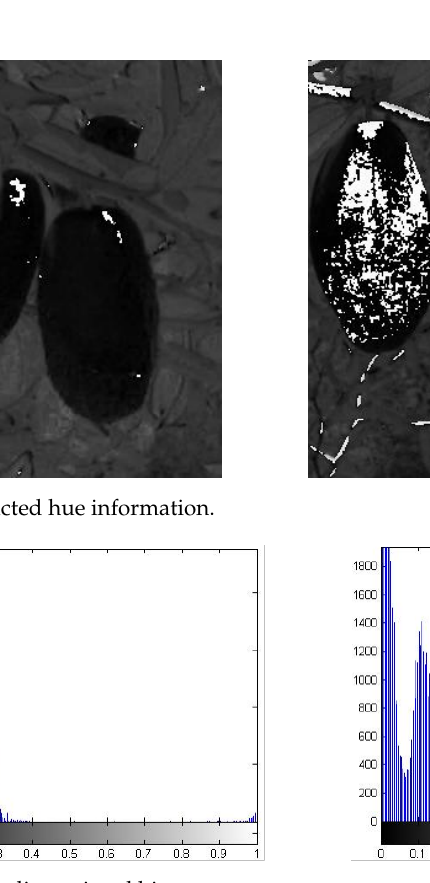
Figure 10. Two-dimensional histogram.